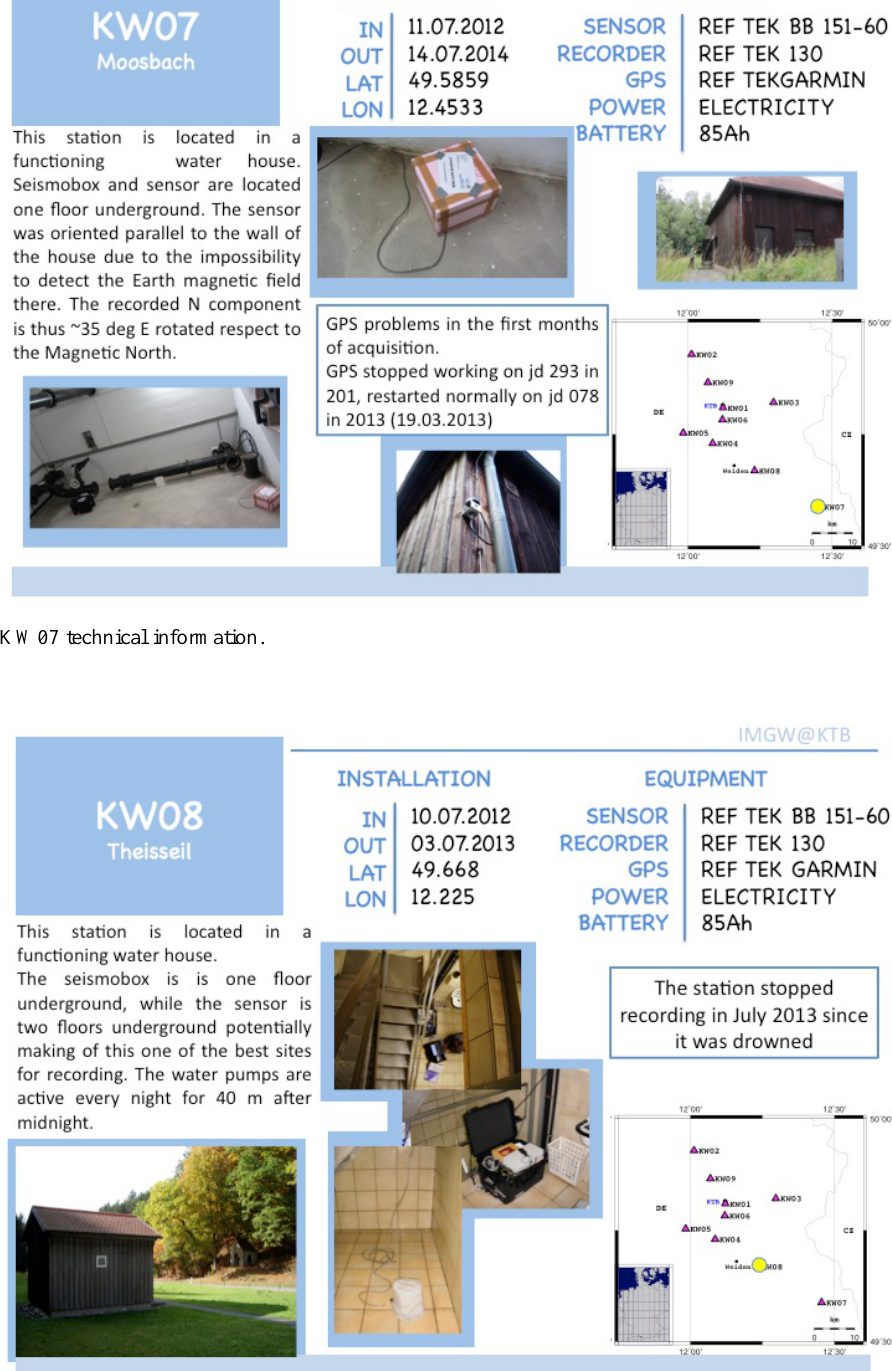
Figure A8. Station KW08 technical